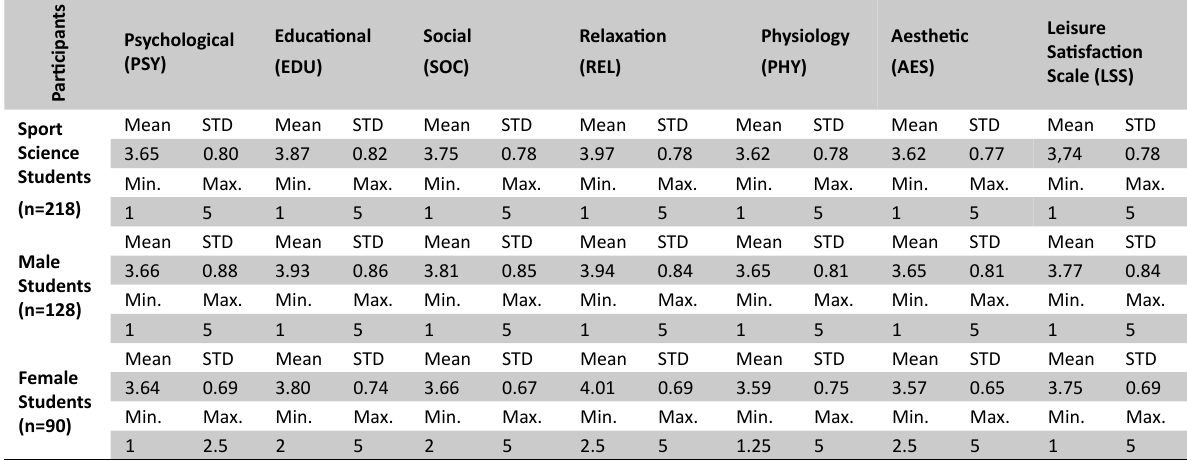
Table 4. Average, standard deviation and range variability values of the Leisure Satisfaction Scale (LSS) of the sport science students